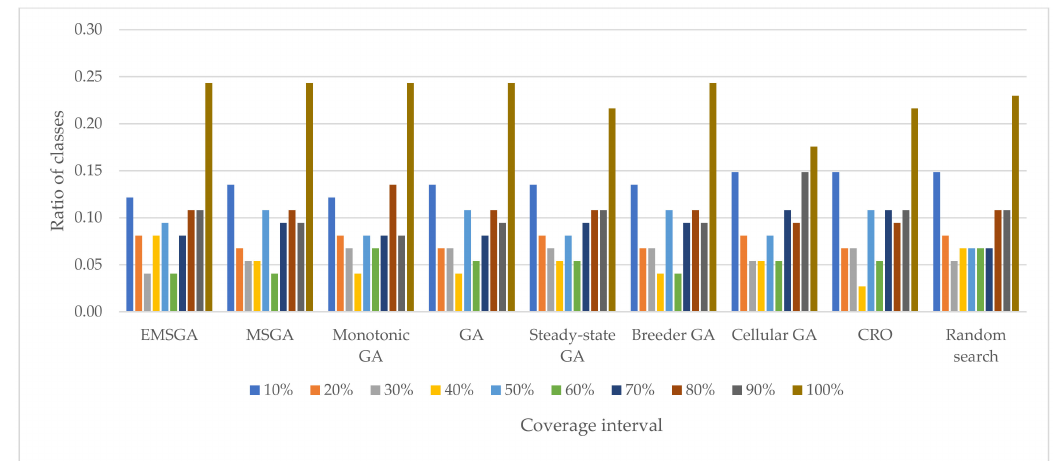
Figure 6. Proportion of classes for different branch coverage